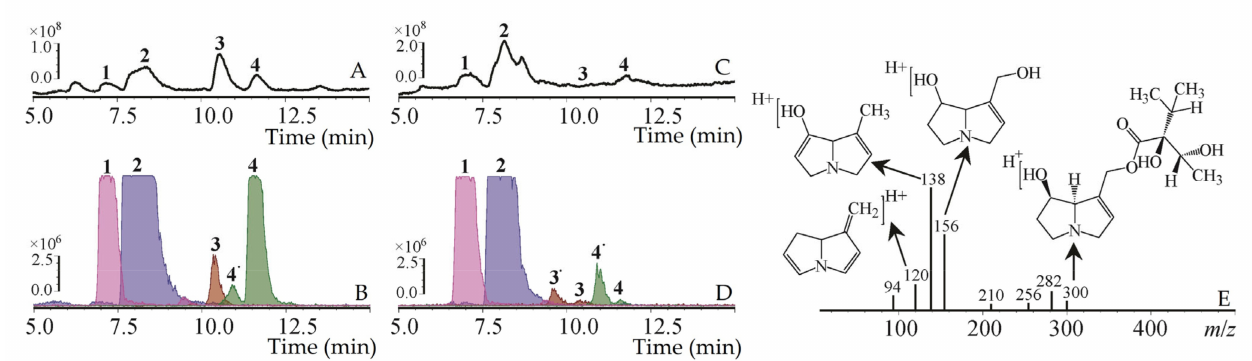
Figure 2. Fragments of HPLC-ESI-MS chromatograms of Mertensia stylosa ( A , B ) and M. serrulata ( C , D ) herb extracts (Total Ion Chromatogram or TIC mode, positive ionization; ( A , C )) and (SIM mode, positive ionization, m/z 300, 316, 342 and 358; ( B , D )). Compounds are numbered as listed in Table 2. ( E ) MS/MS spectrum of lycopsamine ( 1 , positive